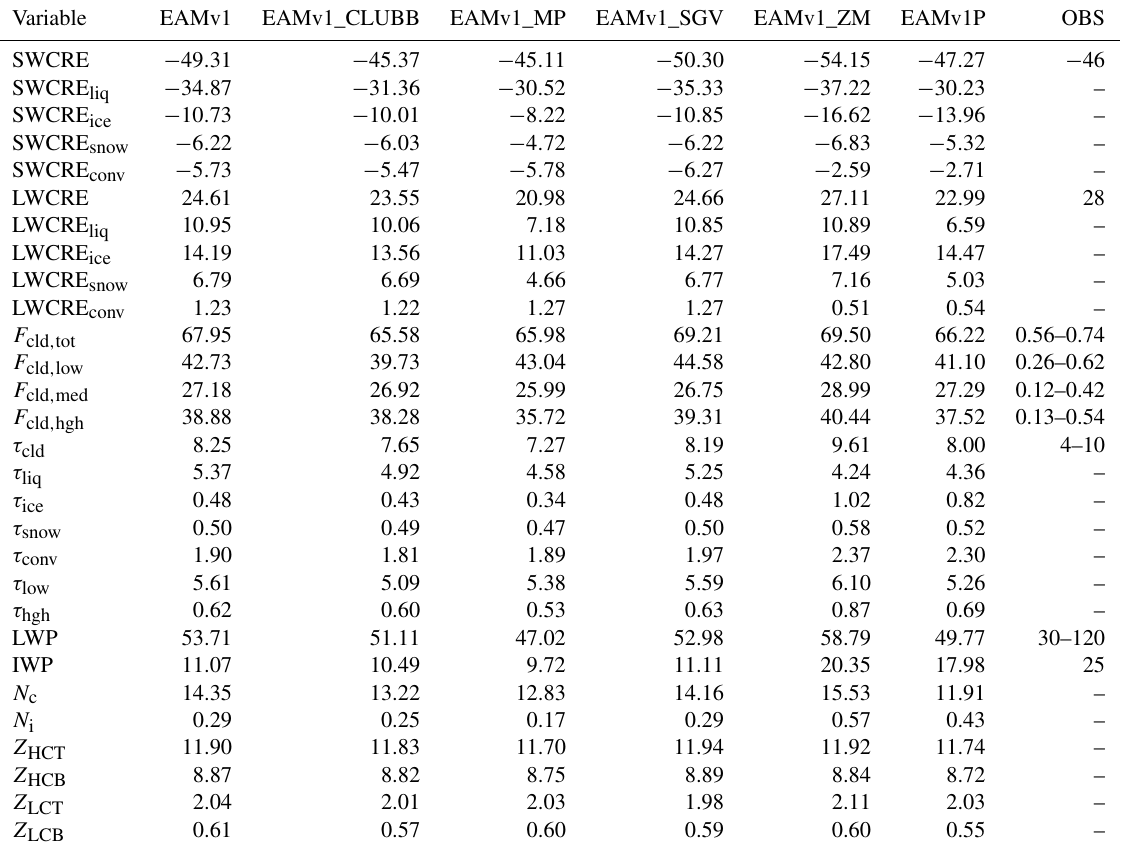
F cld , tot 67.95 F cld , med 27.18 F cld , hgh